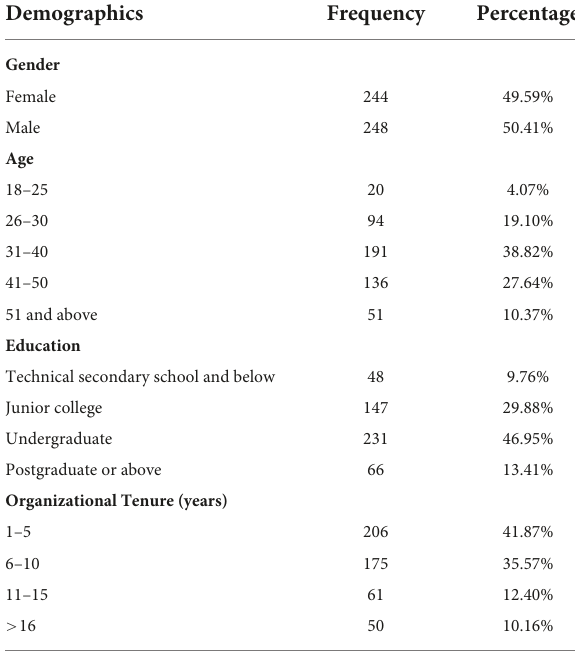
TABLE 1 Demographics analysis ( N =